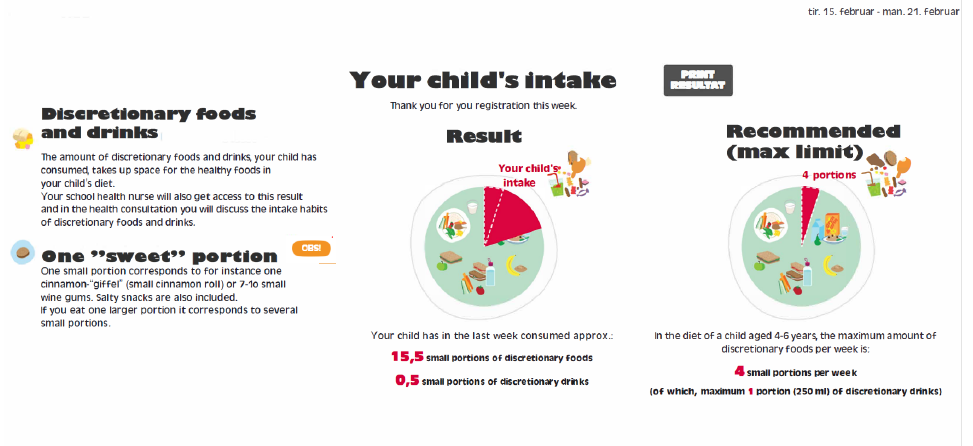
Figure 1. Screen shot of the result webpage from the SRFS. The pie chart to the right is showing the guideline for maximum intake of discretionary foods and drinks. The left pie chart shows the child’s actual intake of discretionary foods and drinks. To the left is explained what a portion of discretionary foods and drinks is and why these foods should be limited in a healthy diet. The original Danish text in this figure has been translated to English.